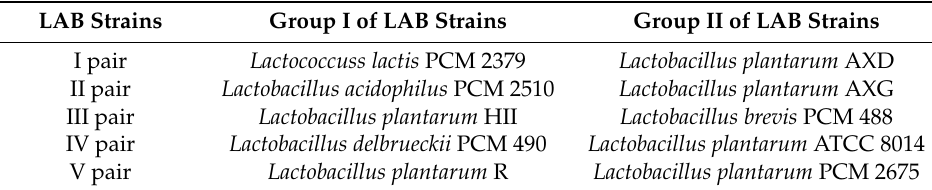
Table 3. Pairs of LAB strains used for